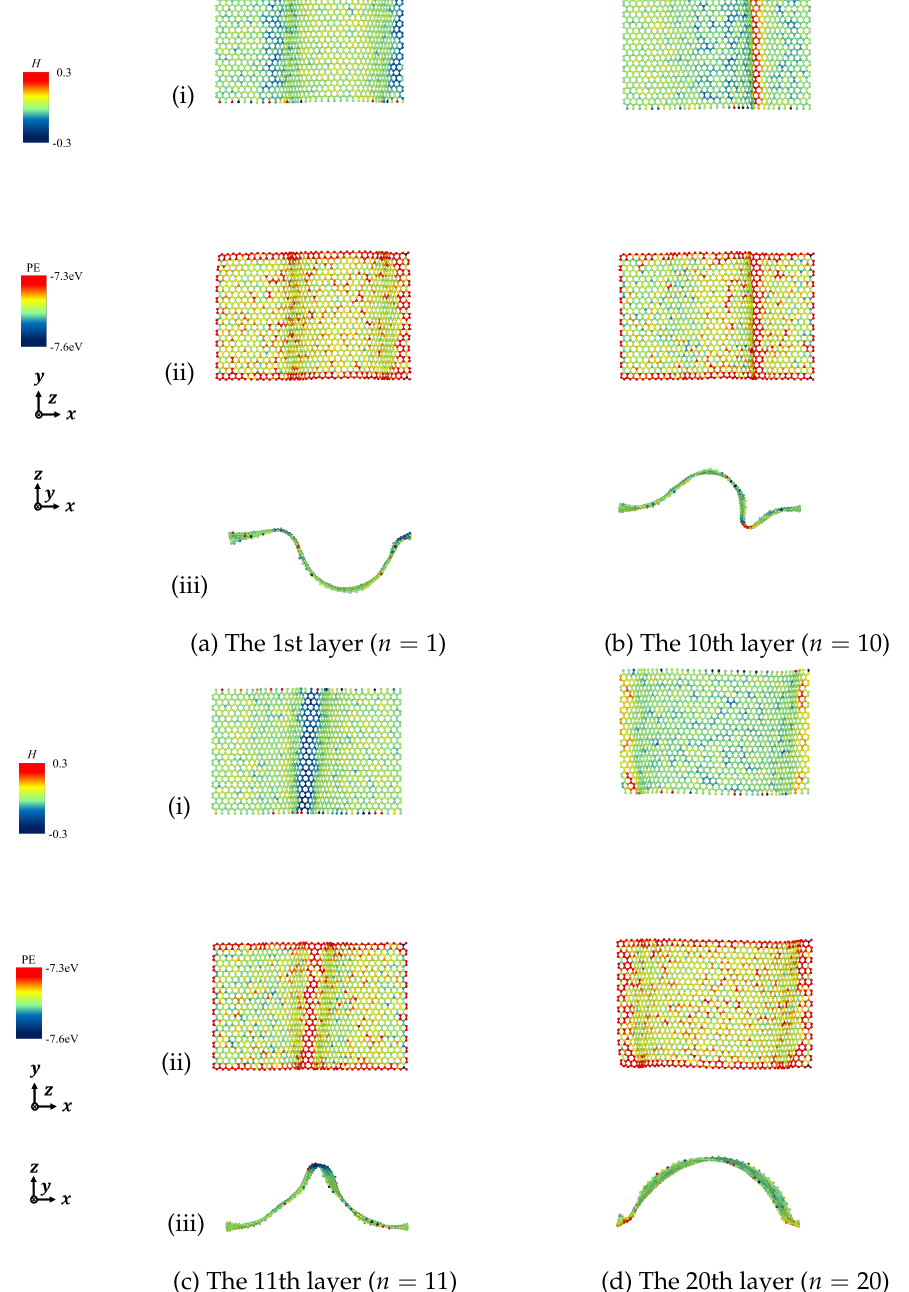
Figure 14. Mean curvature and site potential energy of curved surface of zigzag graphite under compression ε = 0.20. (i) Site mean curvature, (ii) Site potential energy, and (iii) Mean curvature with deformation.